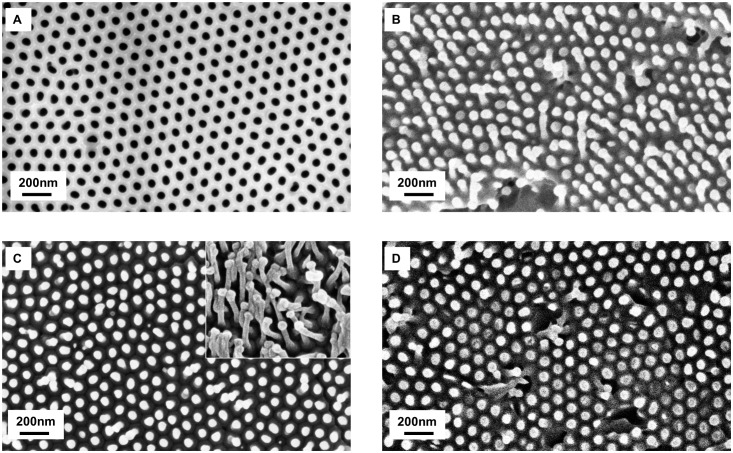
SEM images of AAO mold and nanostructured ABS.(A) AAO mold; (B) ABS nanostructured with polymer wetting solution (technique 1); (C) Two areas of nanostructured ABS Film (technique 2); (D) Injected ABS nanostructured with heat plate (technique 3)